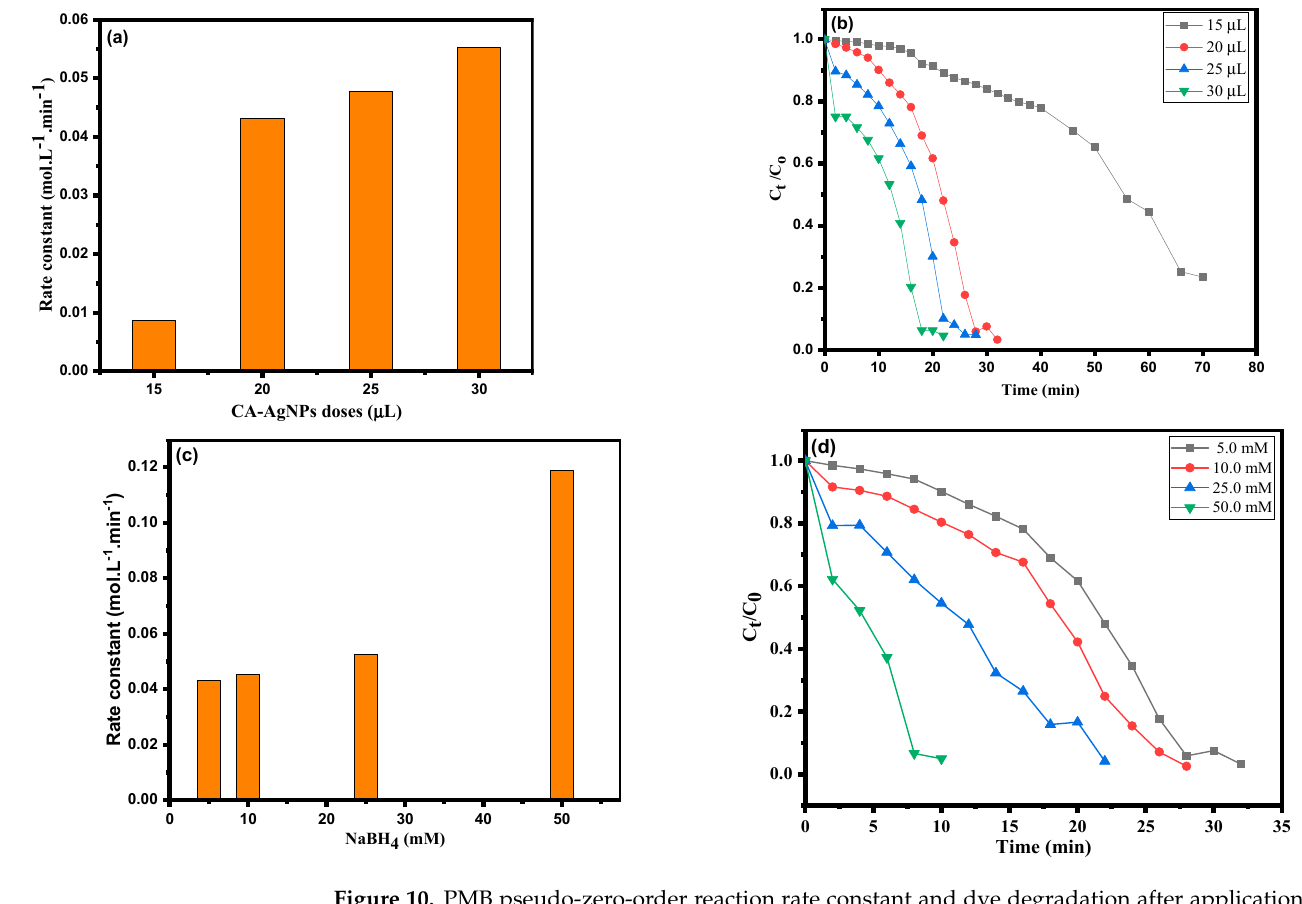
Figure 10. PMB pseudo-zero-order reaction rate constant and dye degradation after applications; ( a ) Different doses of 0.05% CA-AgNPs (15, 20, 25 and 30 µ L) at constant 5.0 mM NaBH 4 concentration; ( b ) C t /C o vis Time plots at different CA-AgNPs concentrations; ( c ) Different concentration of NaBH 4 (5, 10, 25 and 50 mM) at constant CA-AgNPs (20 μ L, 0.05%); ( d ) C t /C o vis Time plots at different NaBH 4 concentrations.